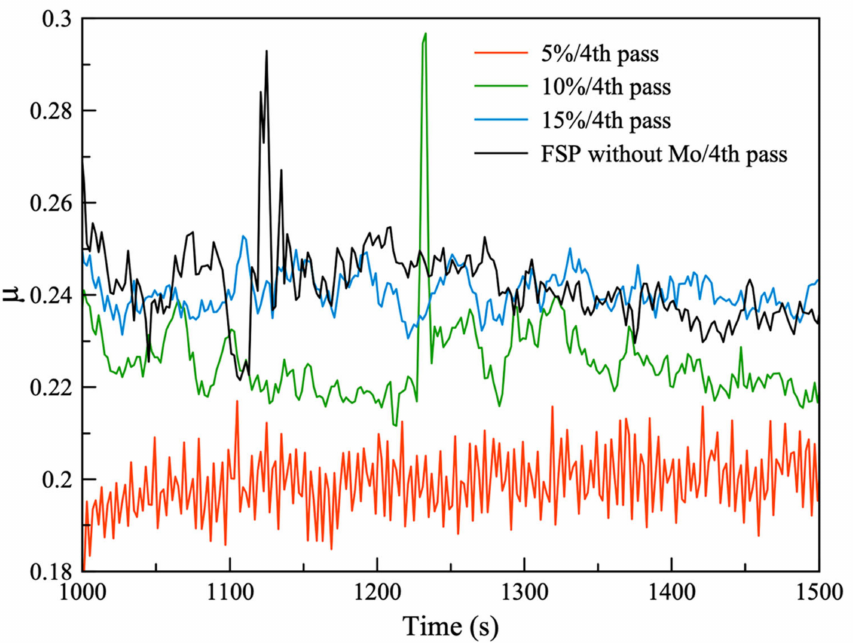
Figure 12. Friction coefficients ( µ ) of samples after four passes obtained in dry sliding friction